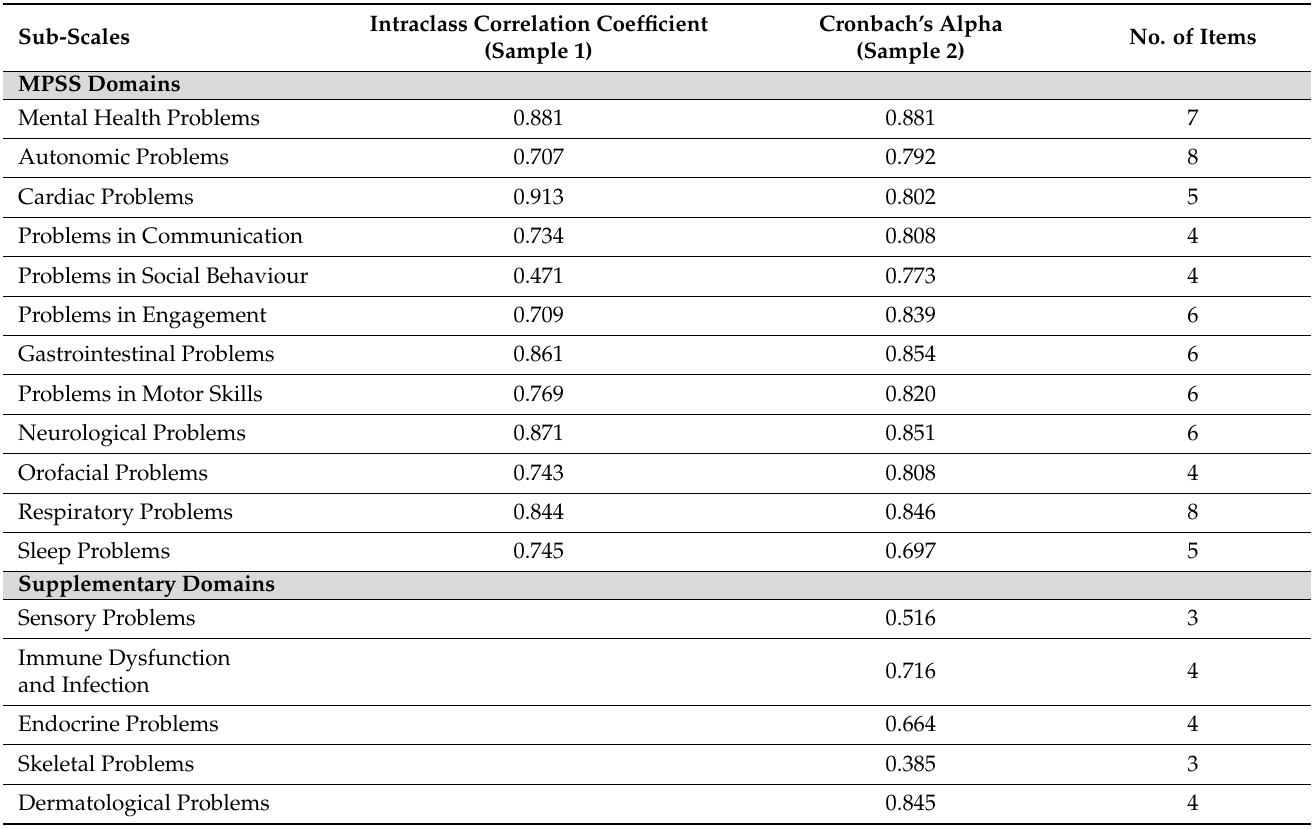
Table 4. Cronbach’s alpha and intraclass correlation